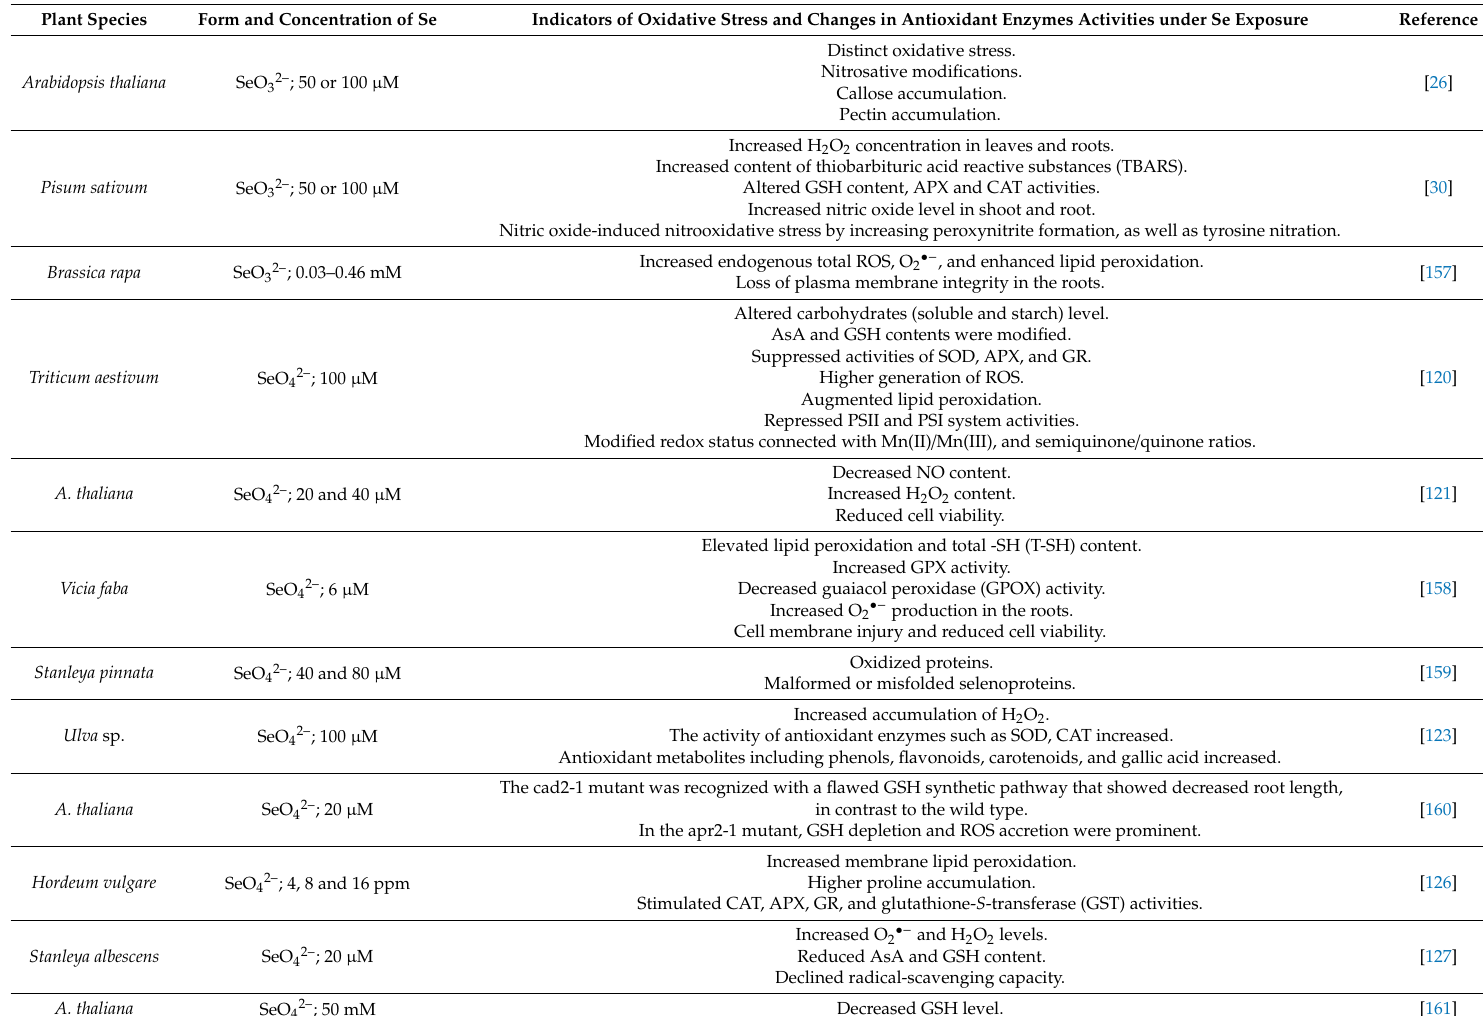
Table 2. Evidence for Se-induced oxidative stress in